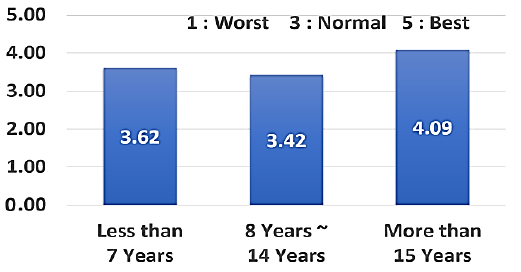
Figure A4. Users’ understanding on the term ‘CNT’ by experience of GPS plotter usage. Average (1: Worst to 5: Best).